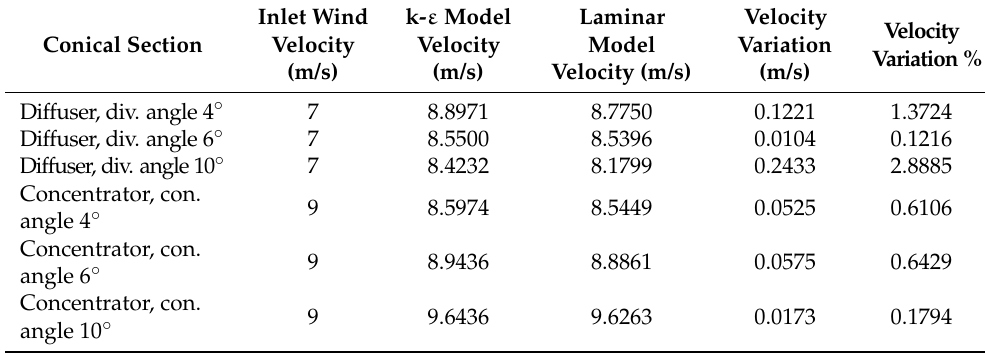
Table 2. Comparison of simulation studies with the k- ε model and laminar model.